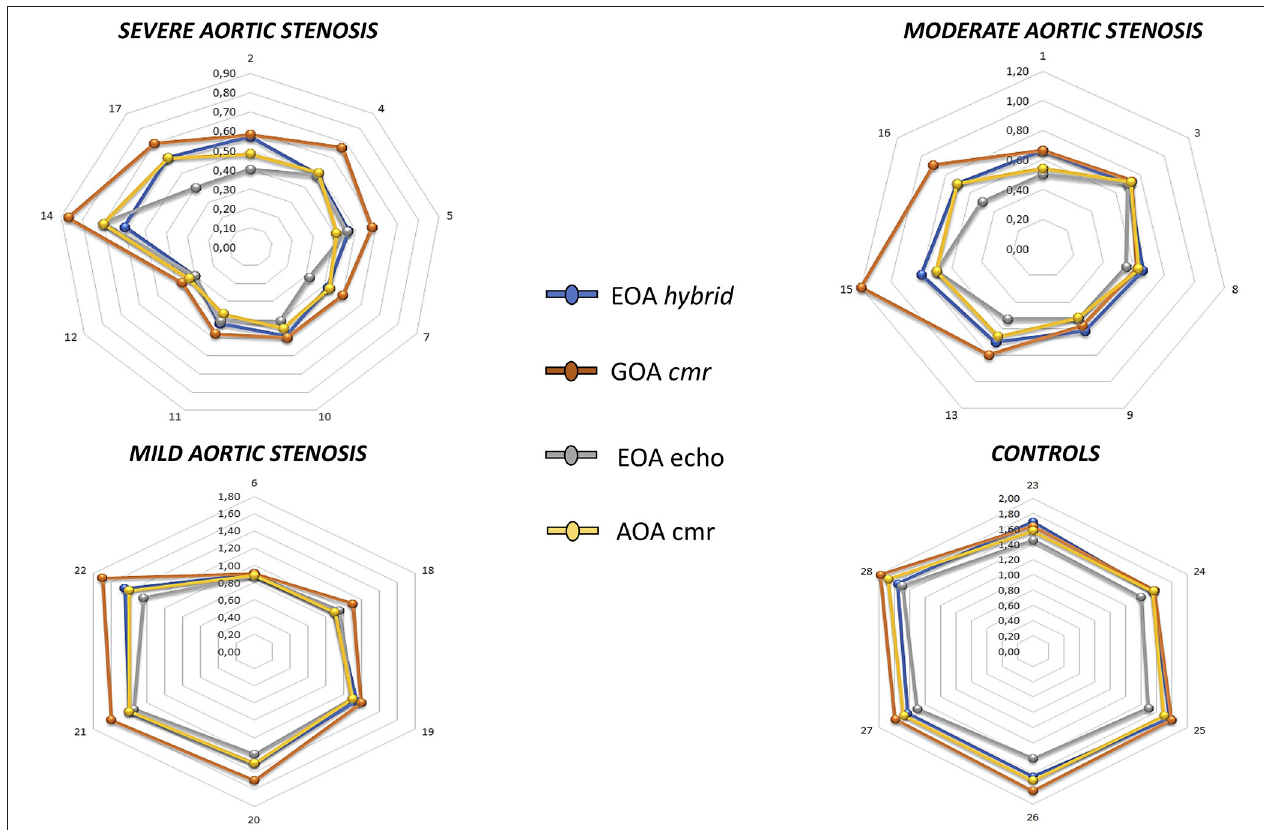
FIGURE 5 | Spider diagrams showing individual aortic valve area estimates with different methods in controls and aortic stenosis patients. All measurements have been indexed to body surface area and reported as cm 2 /m 2 . AOA, aliased orifice area; EOA, effective orifice area; CMR, cardiovascular magnetic resonance; GOA, geometric orifice area; echo, echocardiography; hybrid, combined echo-CMR assessment.